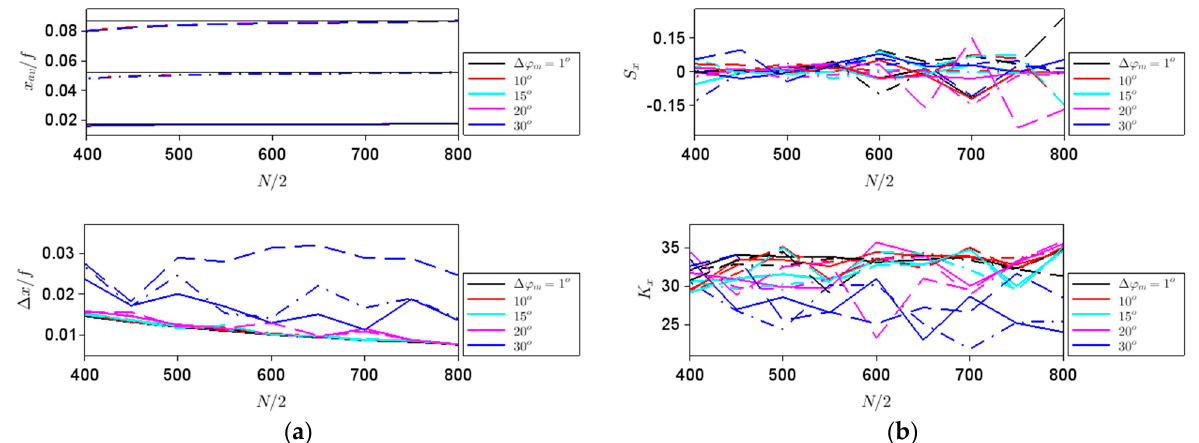
Figure 6. Dependence on the aperture size of ( a ) the transverse average position and spatial extent of the focalized beam and ( b ) of S x and K x for different phase steps indicated in the legend and for θ = 1° (solid line), 3° (dashed–dotted line) and 5° (dashed line).